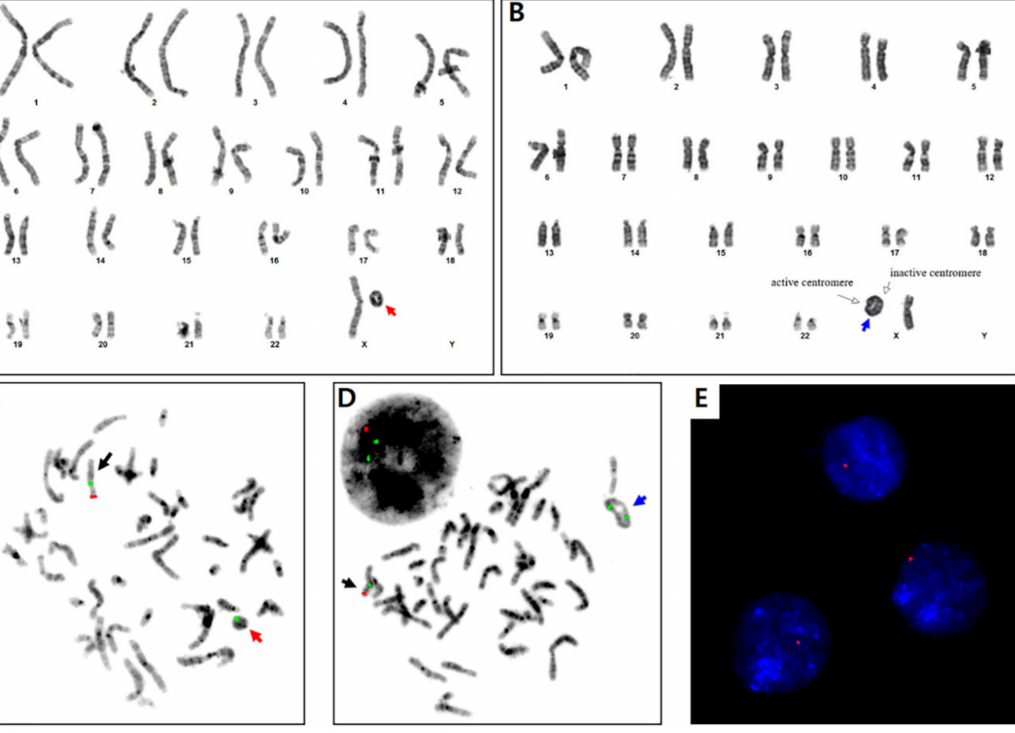
Figure 2. Chromosome study showed ( A ) a ring chromosome X (red arrow) in which breakage and reunion points are Xp22.2 and Xq23, and ( B ) a pseudodicentric ring chromosome X (blue arrow) with break and reunion at Xp22.2q27 and Xq25p11.2. Active centromere (Left white arrow) was on Xp22.2q27. ( C , D ) Metaphase fluorescent in situ hybridization (FISH) using an LSI KAL (on Xp22.3) / CEP X (on Xp11.1-q11.1) probe (Vysis, Dual Color Probe) showed a normal X chromosome (black arrow; one green and one red signal), a ring chromosome X with loss of the KAL gene (one green signal), and a pseudodicentric ring chromosome X with loss of KAL (two green signals). ( E ) Interphase FISH study using a TelVysion Xq / Yq probe (Vysis, Single Color probe) showed a single Xq telomere signal (red), indicating Xq telomere loss in each cell. Magnification, ×